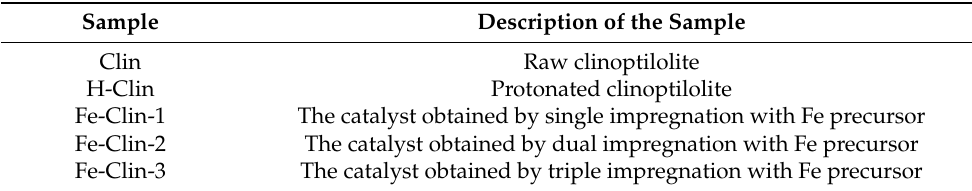
Figure 11. Protonated clinoptilolite ( A ) and Fe-clinoptilolite catalyst formed into pellets ( B ). Table 4. The list of the samples with their codes and